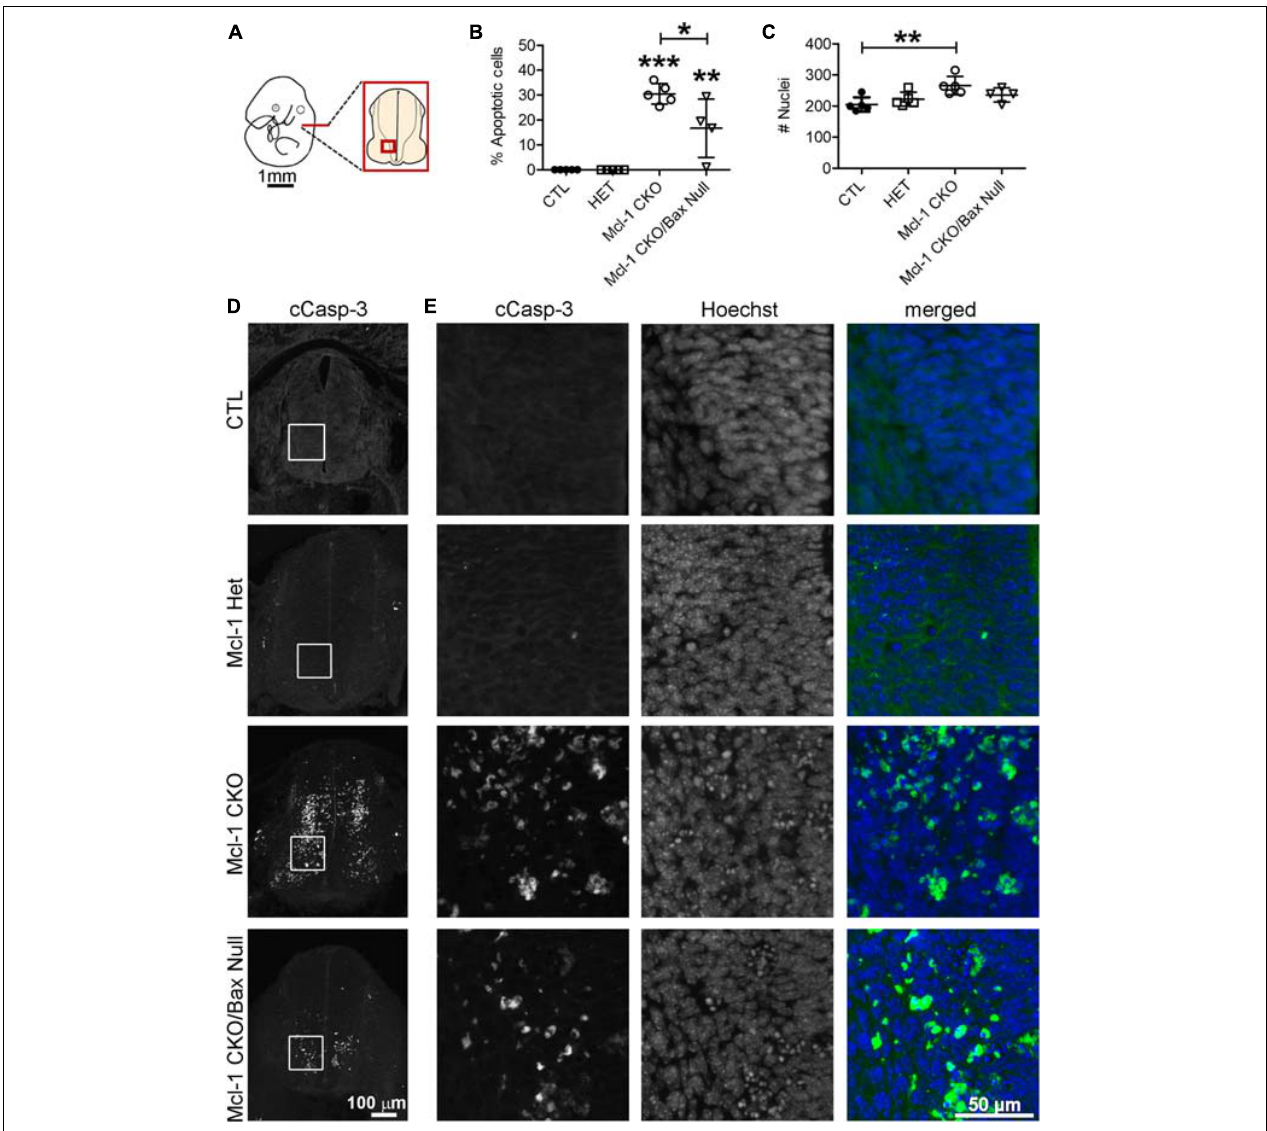
FIGURE 7 | Incomplete rescue of NPC cell death in the developing spinal cord of Mcl-1 CKO/BaxNull embryos. (A) Line diagram of an E11 embryo depicting the location of spinal cord sections. (B) The number of cCasp-3 + cells were quantified within a 125 µ m × 125 µ m area (boxed area in D, E) and represented as a percentage of the total number of Hoechst + nuclei. Co-deletion of Bax in the Mcl-1 CKO/BaxNull embryo rescued 50% of NPC from apoptosis in the ventral spinal cord. (C) A comparison of the total number of Hoechst + nuclei revealed more cells in the Mcl-1 CKO, which may be due to quantification of apoptotic bodies versus healthy nuclei. A one-way ANOVA was performed on the means followed by Tukey’s multiple comparison test. (D) Representative sections through the ventral spinal cords of E11 controls Mcl-1 Het, Mcl-1 CKO and Mcl-1 CKO/BaxNull embryos. (E) Higher magnification of boxed counting areas in D showing individual panels for cCasp-3 immunostaining, Hoechst and merged (cCasp-3 = green, Hoechst = blue). * p < 0.05 , ** p < 0.01 , *** p < 0.001 , and error bars represent ±